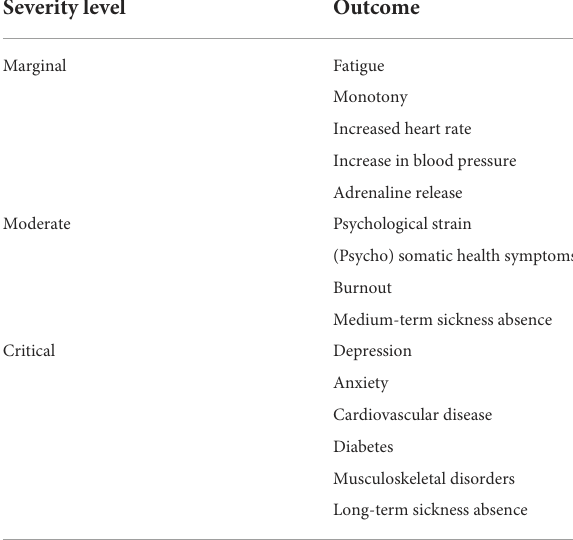
TABLE 3 Possible classification of outcomes to